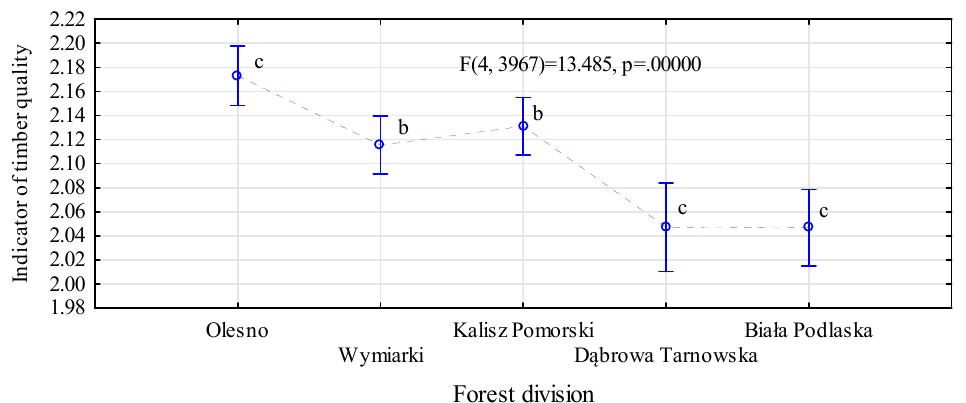
Figure 1. The impact of the origin of long logs on the resulting main timber (lower case letters denote homogeneous groups, as determined by the NIR test).